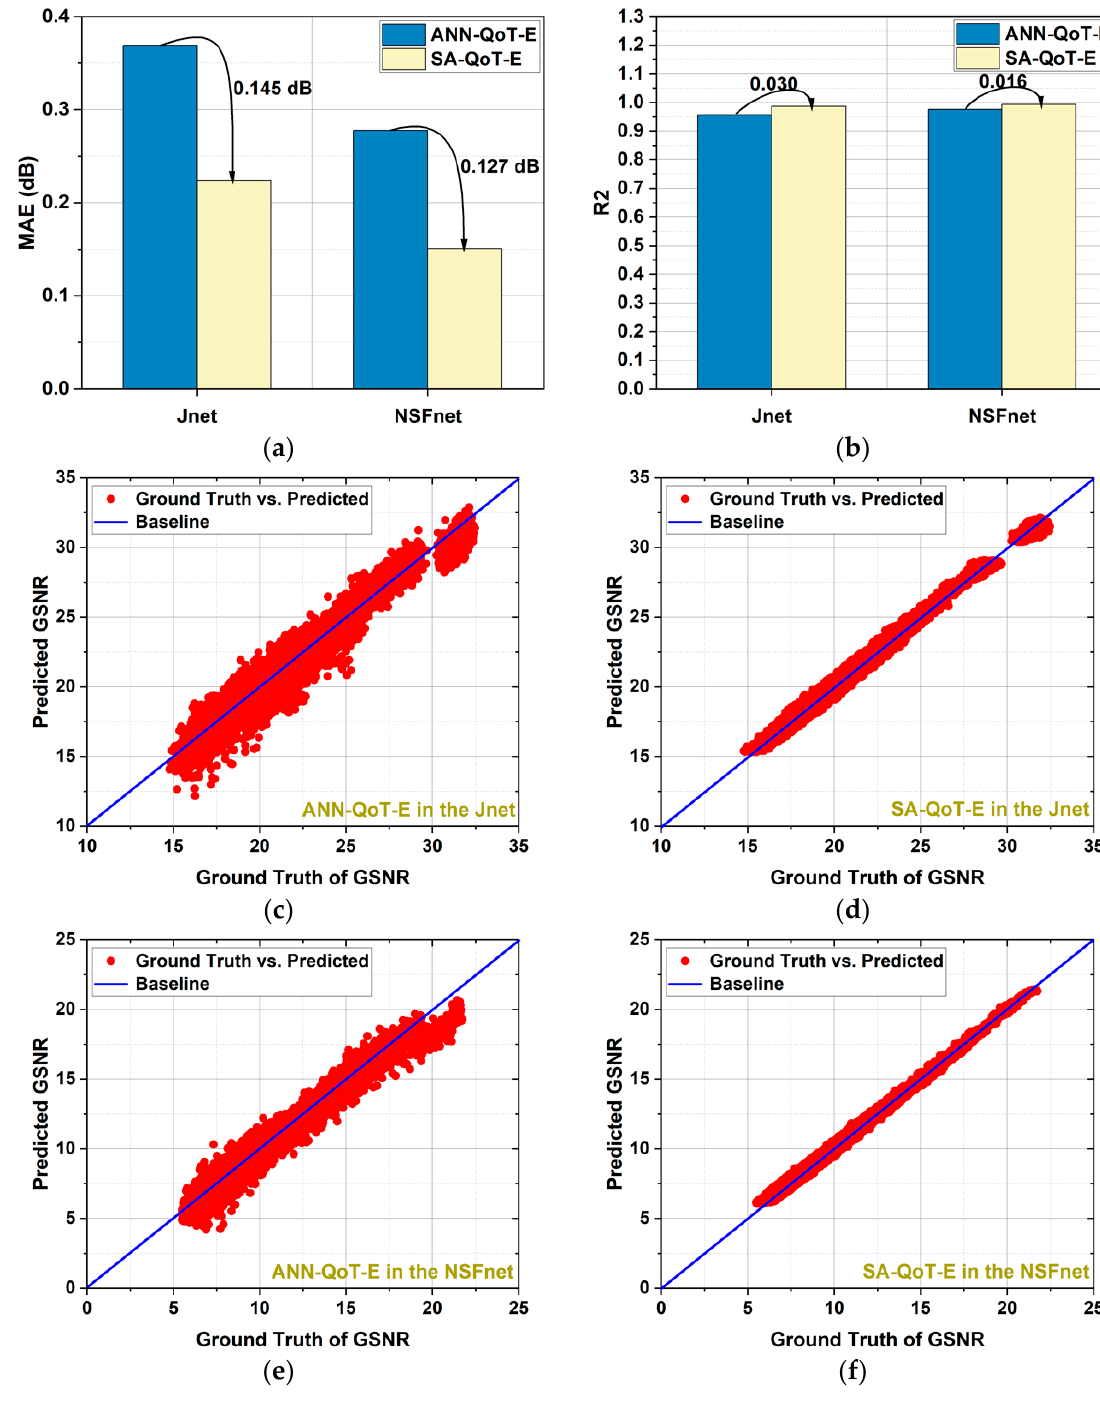
Figure 5. Estimation accuracy of the ANN-QoT-E and the SA-QoT-E: ( a ) testing MAE of two models in the Jnet and NSFnet; ( b ) testing R2 of two models in the Jnet and NSFnet; ( c ) ground truth of GSNR vs. predicted GSNR based on the ANN-QoT-E in the Jnet; ( d ) ground truth of GSNR vs. predicted GSNR based on the SA-QoT-E in the Jnet; ( e ) ground truth of GSNR vs. predicted GSNR based on the ANN-QoT-E in the NSFnet; ( f ) ground truth of GSNR vs. predicted GSNR based on the SA-QoT-E in the NSFnet.